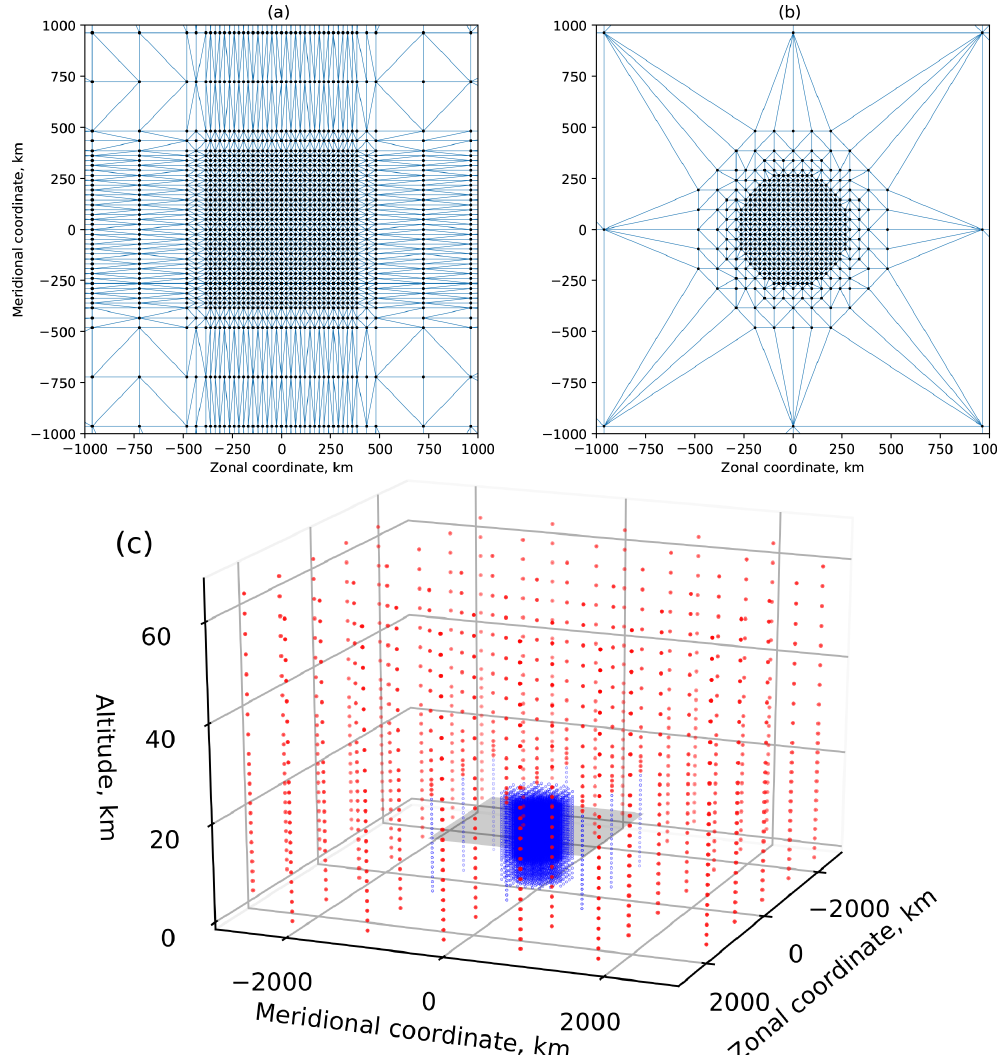
Figure 2. Panels (a) and (b) : horizontal cuts of retrieval grids. Dots show grid points; blue lines indicate Delaunay cell boundaries. Panel (a) shows the full initial grid for retrievals A, B and C (all horizontal layers of this grid are identical), (b) shows the thinned-out grid for retrieval D (cut at 11km). Panel (c) is the grid for retrieval D. Radial distance is defined as distance to the vertical line at the centre of the hexagonal flight path (66 ◦ N, 15 ◦ W). Points within the inner core (1000km × 1000km × 20km) are shown in blue, other points are in red, and the shaded rectangle shows the position of the horizontal cut in panel (b)